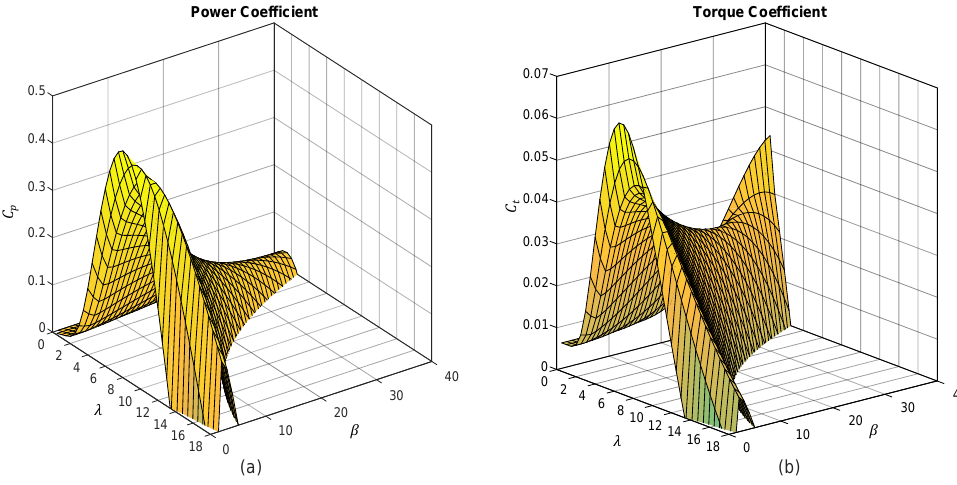
Figure 14. Coefficient proposed by Ovando, Aguayo, and Cotorogea [33–41], with variations of λ and β ; ( a ) power coefficient, ( b ) torque coefficient.